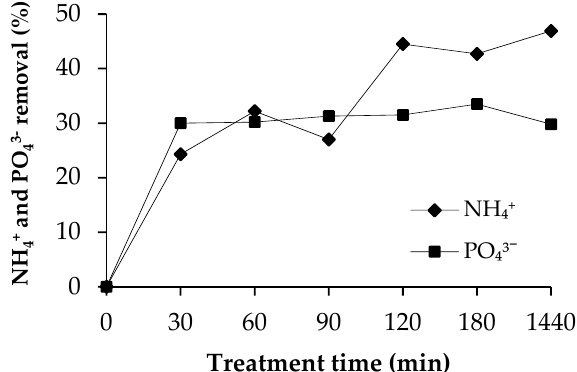
Figure 7. Ammonium nitrogen and phosphate removal percentage using fly ash sludge as a precipitant, at 20 °C.